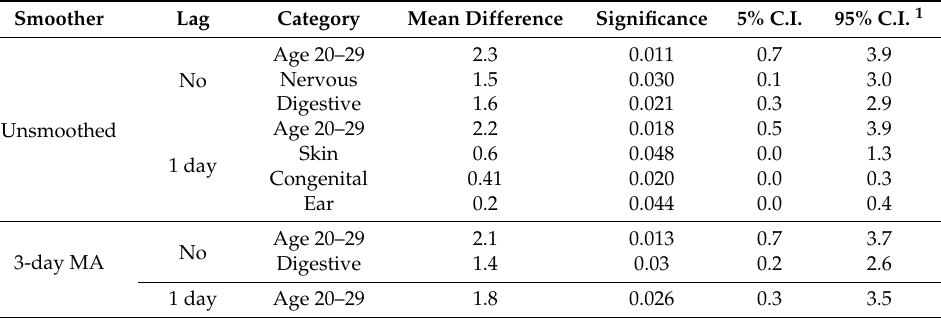
Table 6. Summary of paired t -test results for 37 ◦ C AT threshold heat waves for all smoother and lag combinations. Categories with statistically significant differences between admissions for the heat wave case and control days, significance level, and bootstrapped 5th and 95th percentile confidence intervals about the mean